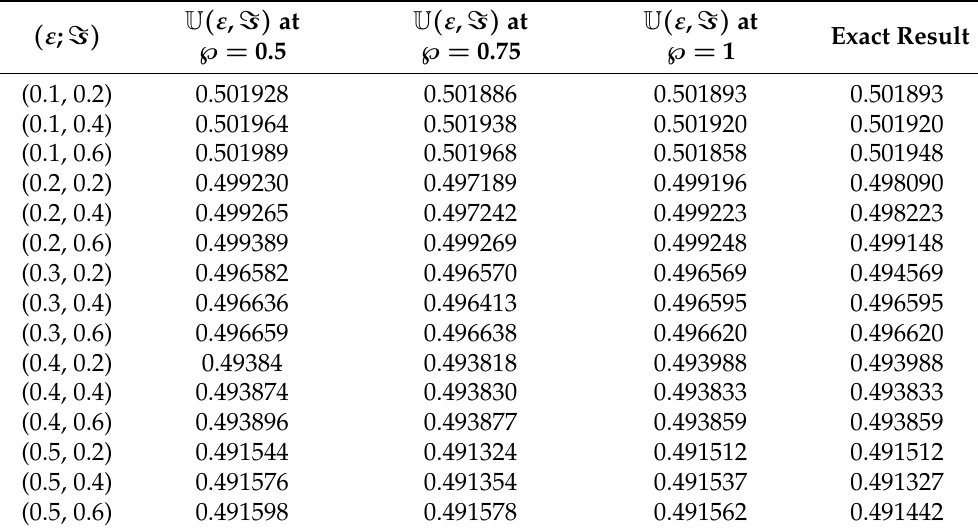
Figure 4. The fractional-order solutions of V ( ε , (cid:61) ) at ℘ of Example 1. Table 1. YDM solution of U ( ε , (cid:61) ) at various fractional-order ℘ of Example